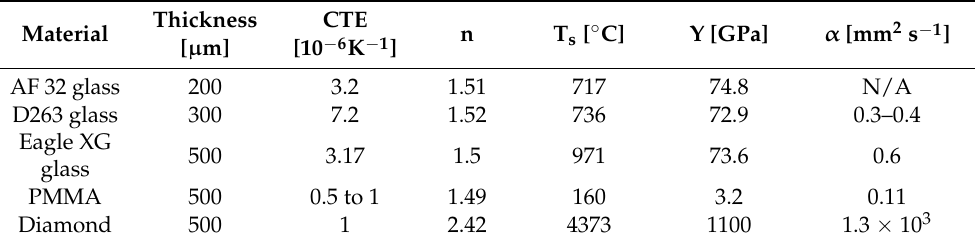
Table 1. Thermal and mechanical specifications of the tested transparent materials. CTE: coefficient of thermal expansion; n: refractive index; Ts: softening point; Y: Young’s modulus (elasticity of the material in tension); α : thermal diffusivity